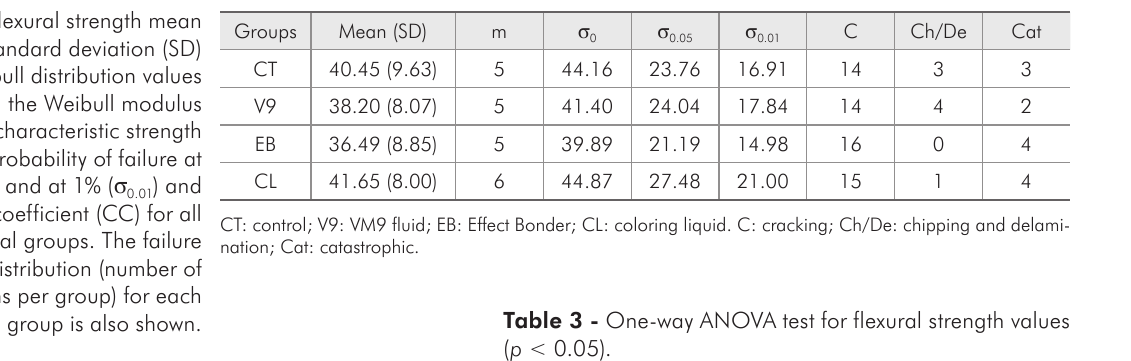
( p < 0.05). Sum of Mean df squares square